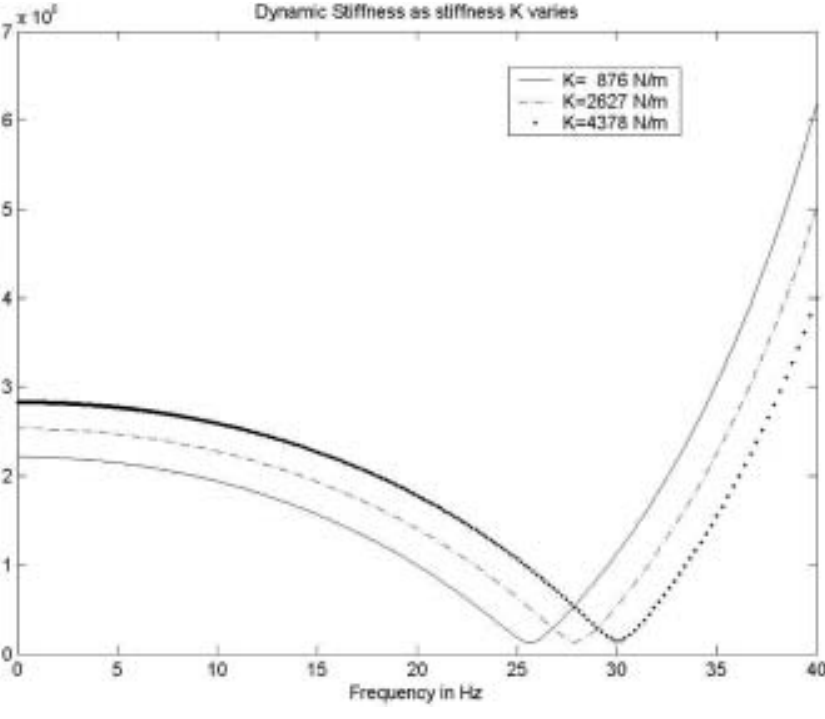
Fig. 6. Dynamic Stiffness as Spring K varies (MATLAB